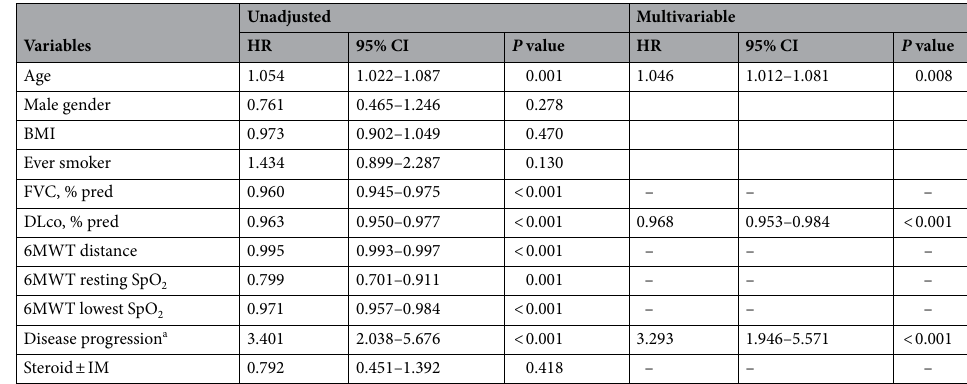
Table 2. Risk factors for AE in patients with IPF assessed by using Cox regression analysis. TLC was excluded for analysis due to close correlation with FVC (r = 0.890). HR hazard ratio, CI confidence interval, AE acute exacerbation, IPF idiopathic pulmonary fibrosis, BMI body mass index, FVC forced vital capacity, DLco diffuse lung capacity of carbon monoxide, TLC total lung capacity, 6MWT 6-min walk test, SpO 2 saturation of pulse oximetry, IM immunosuppressant. a Disease progression was defined as 10% relative decline in FVC for